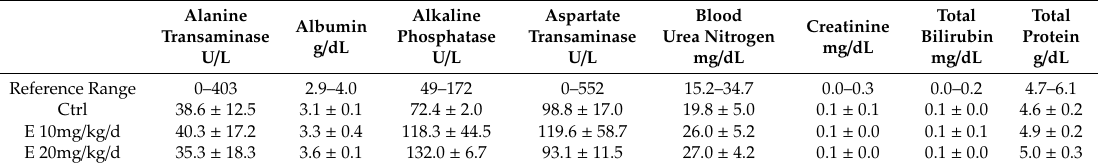
Table 1. Serum levels of multiple biochemical enzymes and markers of liver and kidney function for control, EGCG 10 mg / kg / d, and 20 mg / kg / d at the end of the treatment period. Results are presented as the mean ± SD.